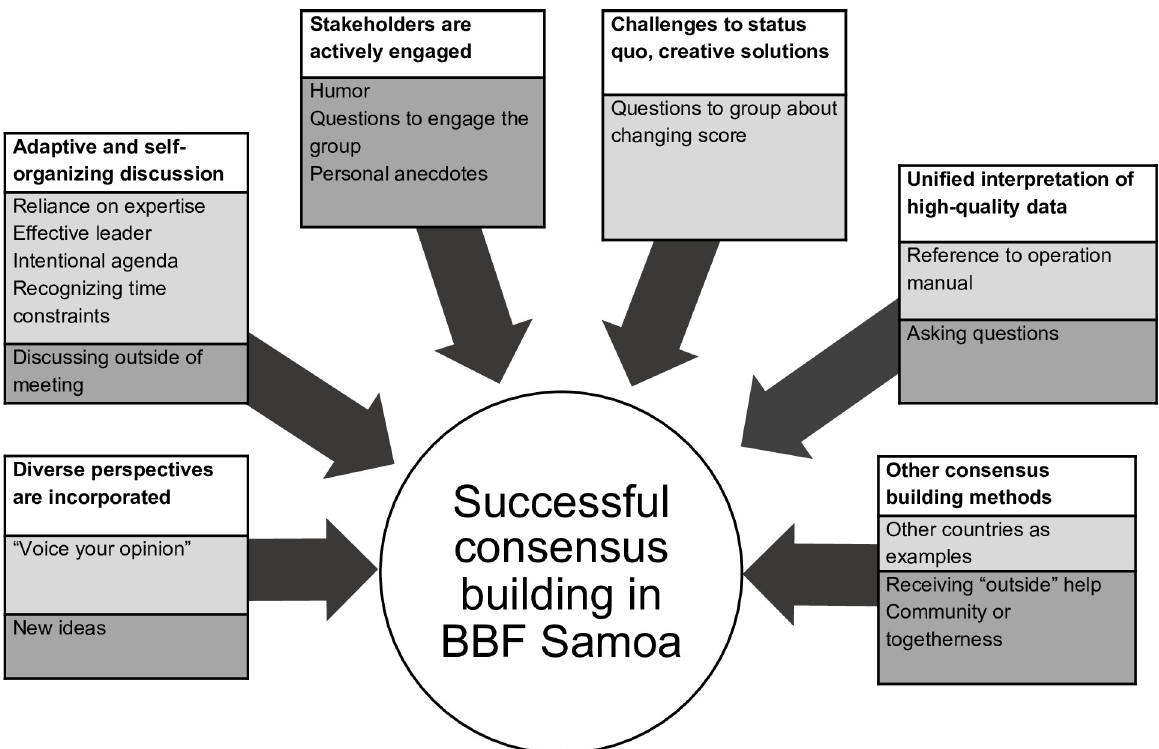
Fig 2. Organization of themes and subthemes. Subthemes are organized into “process-led” (light gray boxes) and “organic” (dark gray boxes) aspects of consensus-building.